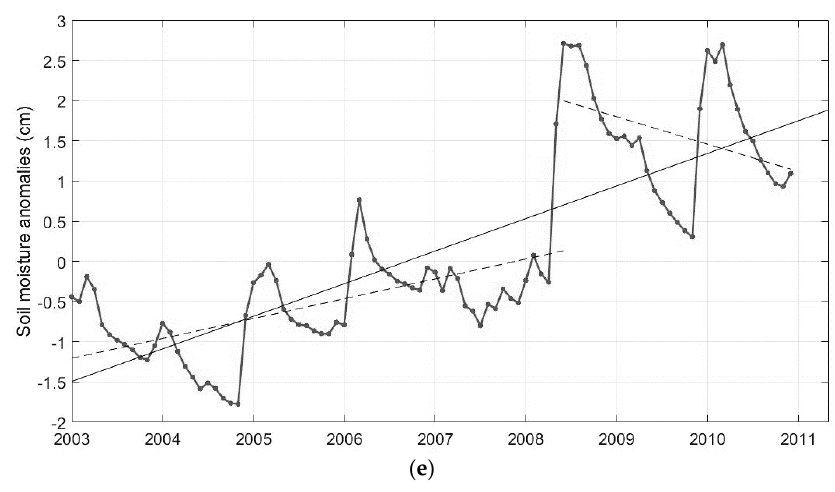
Figure 9. Soil moisture anomalies from GLDAS NOAH from 2003 to 2011. ( a ) First layer of soil moisture (0–10 cm); ( b ) Second layer of soil moisture (10–40 cm); ( c ) Third layer of soil moisture (40–100 cm); ( d ) Fourth layer of soil moisture (100–200 cm); ( e ) Combination of four layers of soil moisture (0–200 cm).